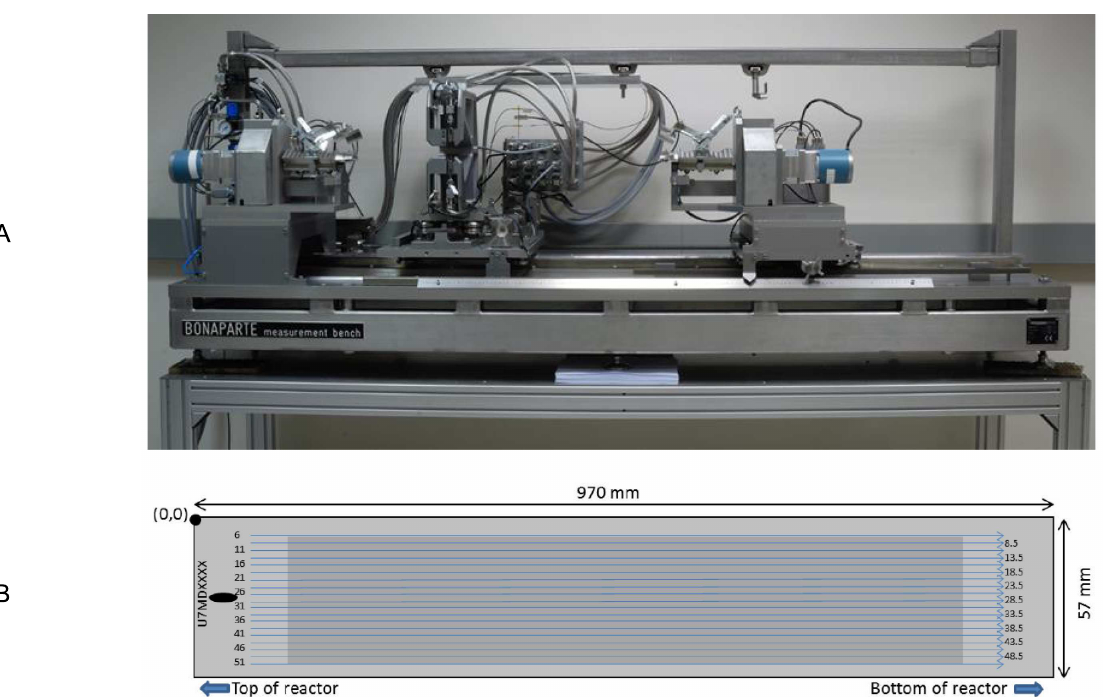
Fig. 5. (A) The BONAPARTE measuring device. (B) Coordinate system adopted for the BONAPARTE measurement results for a typical FUTURE